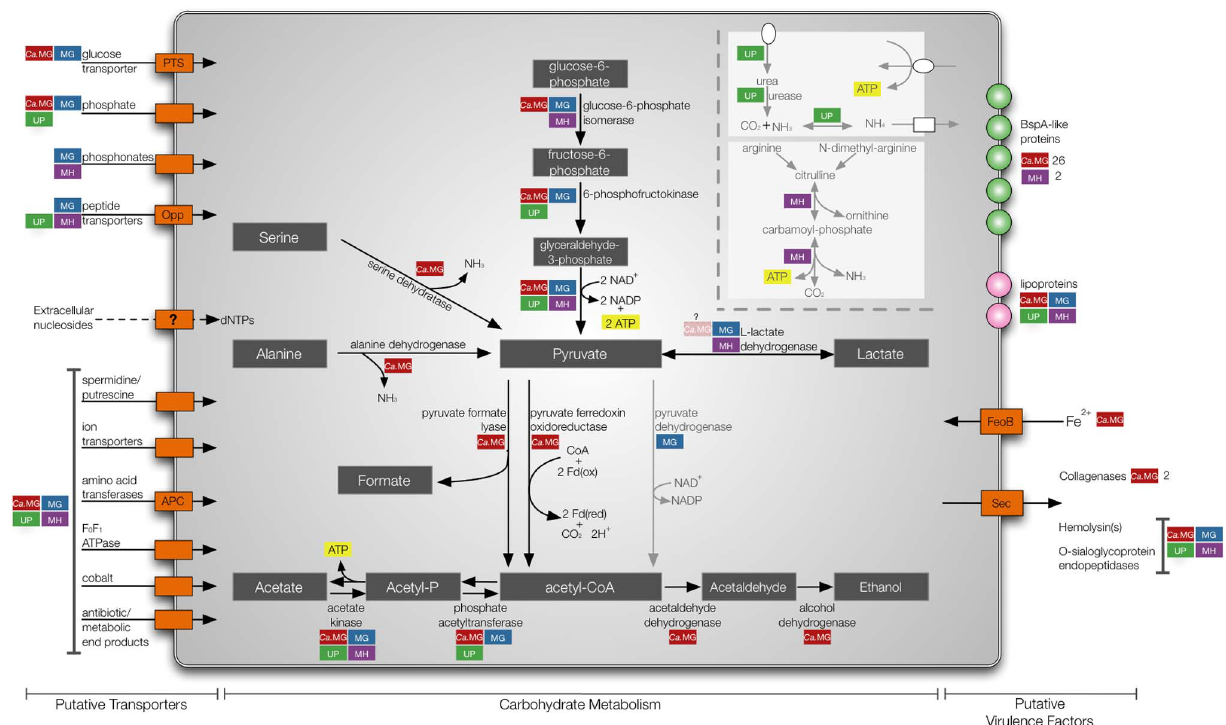
Figure 6. Unique strategies of ‘‘ Ca . M. girerdii’’. Putative transporters, enzymes involved in carbohydrate metabolism and virulence factors are represented in red for ‘‘ Ca . M. girerdii’’. Comparisons with other genital mycoplasmas are indicated with color-coded boxes: M. genitalium (MG, blue) U. parvum (UP, green) and M. hominis (MH, purple). Arrows indicate direction of transport. Light gray arrows represent metabolic strategies unique to other genital mycoplasma. Metabolic reconstruction was performed using ASGARD and careful inspection of manual annotations.